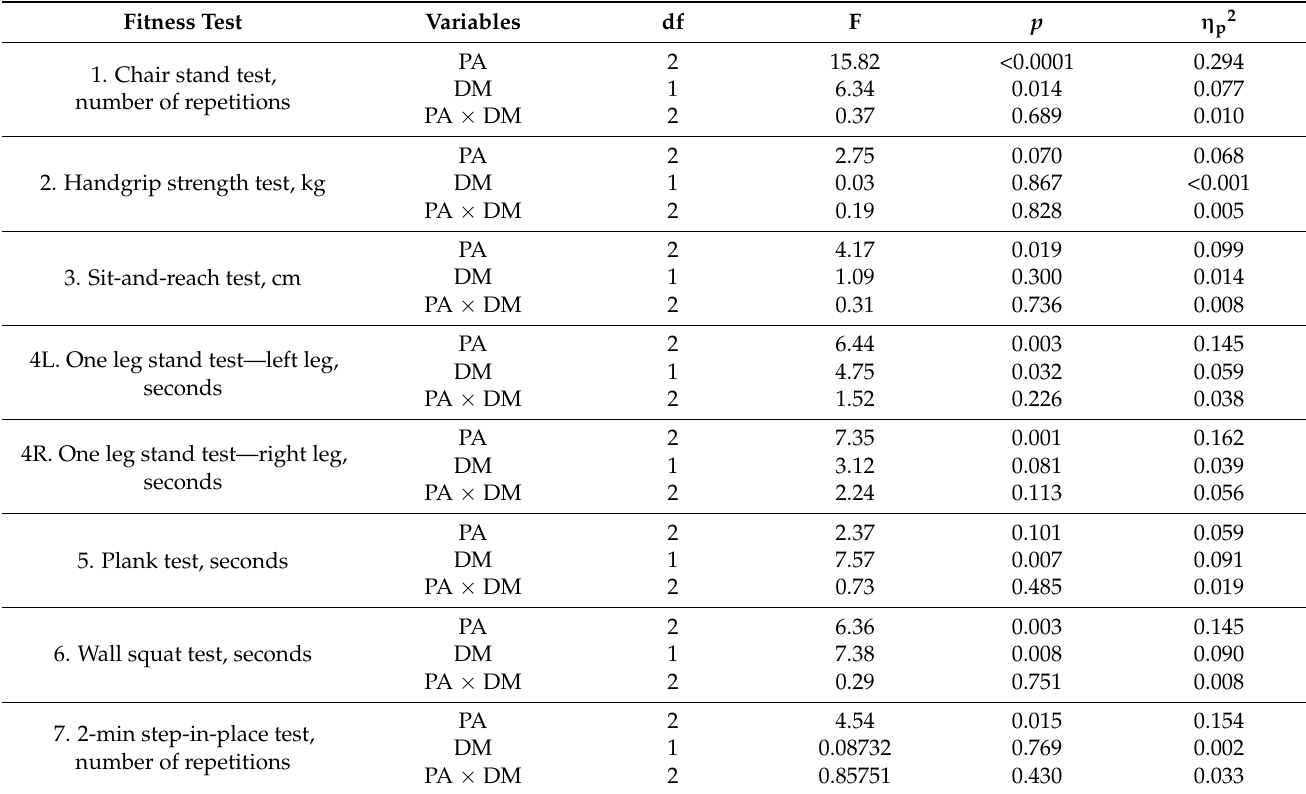
Table 5. Main effects and interaction effect of DM and PA on fitness tests—results of two-way